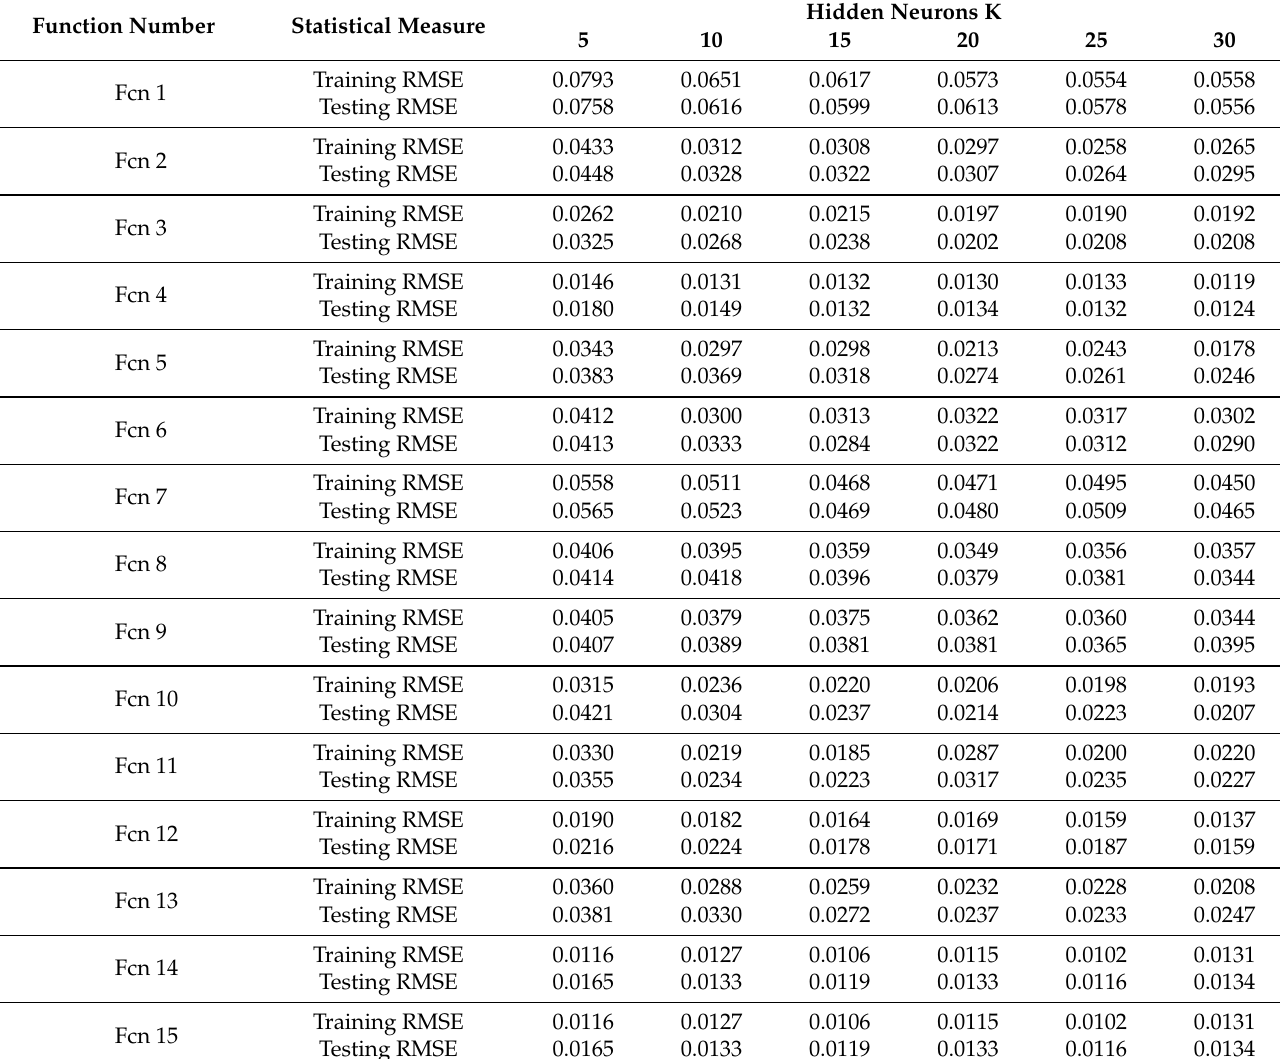
Table 1. The summary of the training and testing RMSE performance of each neural network architecture in BBOB objective